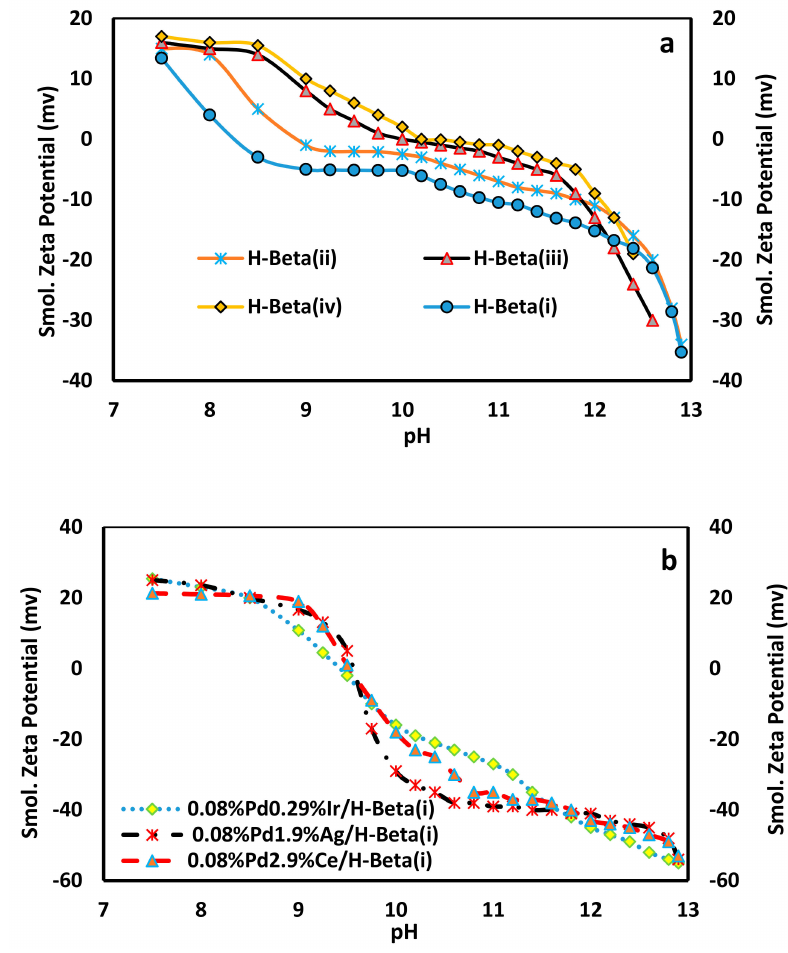
Figure 9. Zeta potential of ( a ) supports and ( b )